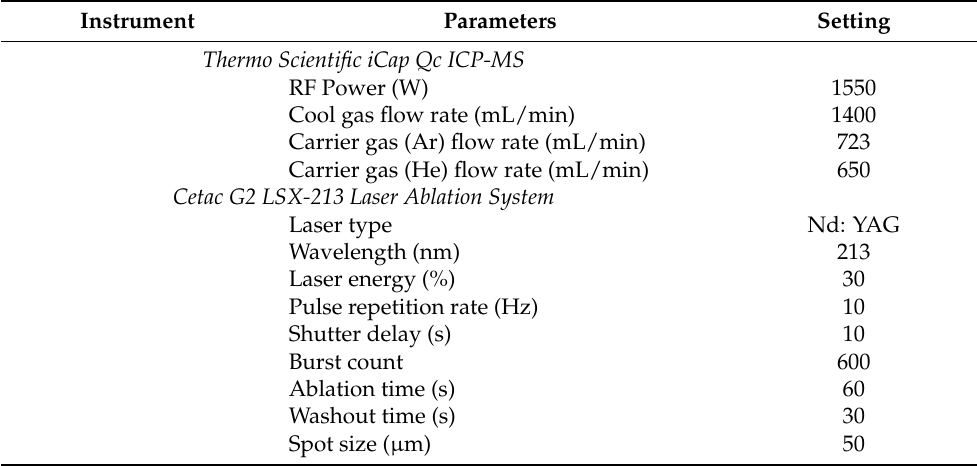
Table A4. Big Ridge Kb-A A4, Big Ridge Millbrig M1–M4, Big Ridge Deicke D1–D7, Brickyard Deicke,